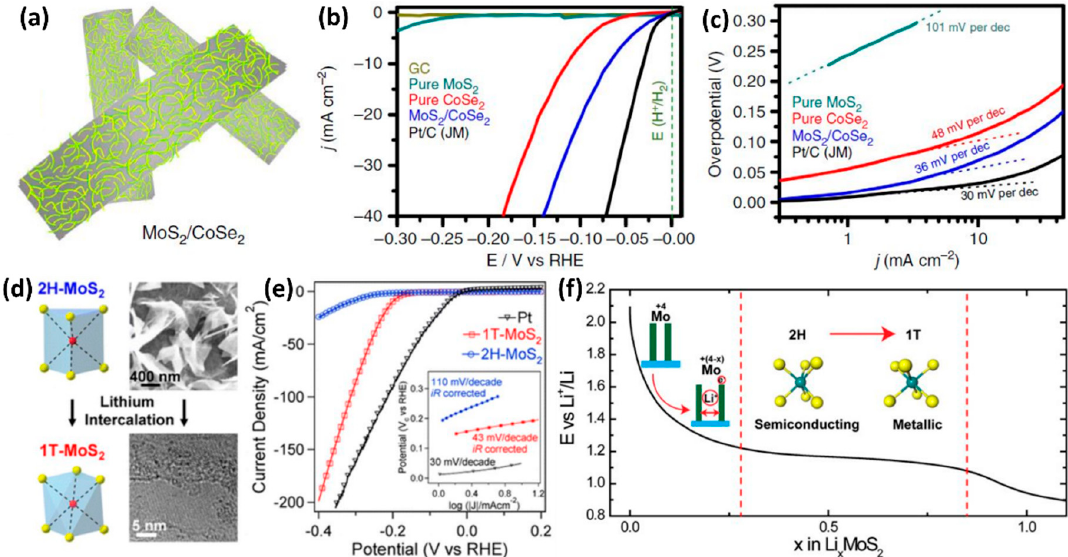
Figure 7. ( a ) Schematic illustration of MoS 2 /CoSe 2 heterostructure [65]. ( b ) Polarization curves and ( c ) Tafel plots of MoS 2 /CoSe 2 hybrid, pure MoS 2 , pure CoSe 2 , and Pt/C. Catalyst loading is about 0.28 mg/cm − 2 [65]. ( d ) Top: the atomic models and SEM image of 2H-MoS 2 . Bottom: the atomic models and HRTEM image of chemically exfoliated 1T-MoS 2 nanosheets [66]. ( e ) Polarization curves and Tafel plots (insert figure) of chemically exfoliated 1T-MoS 2 and as-grown 2H-MoS 2 nanosheets [66]. ( f ) Galvanostatic discharge curve representing the lithiation process in MoS 2 [67]. Reproduced from [65] with permission from copyright 2015 Nature Publishing Group, [66] with permission from